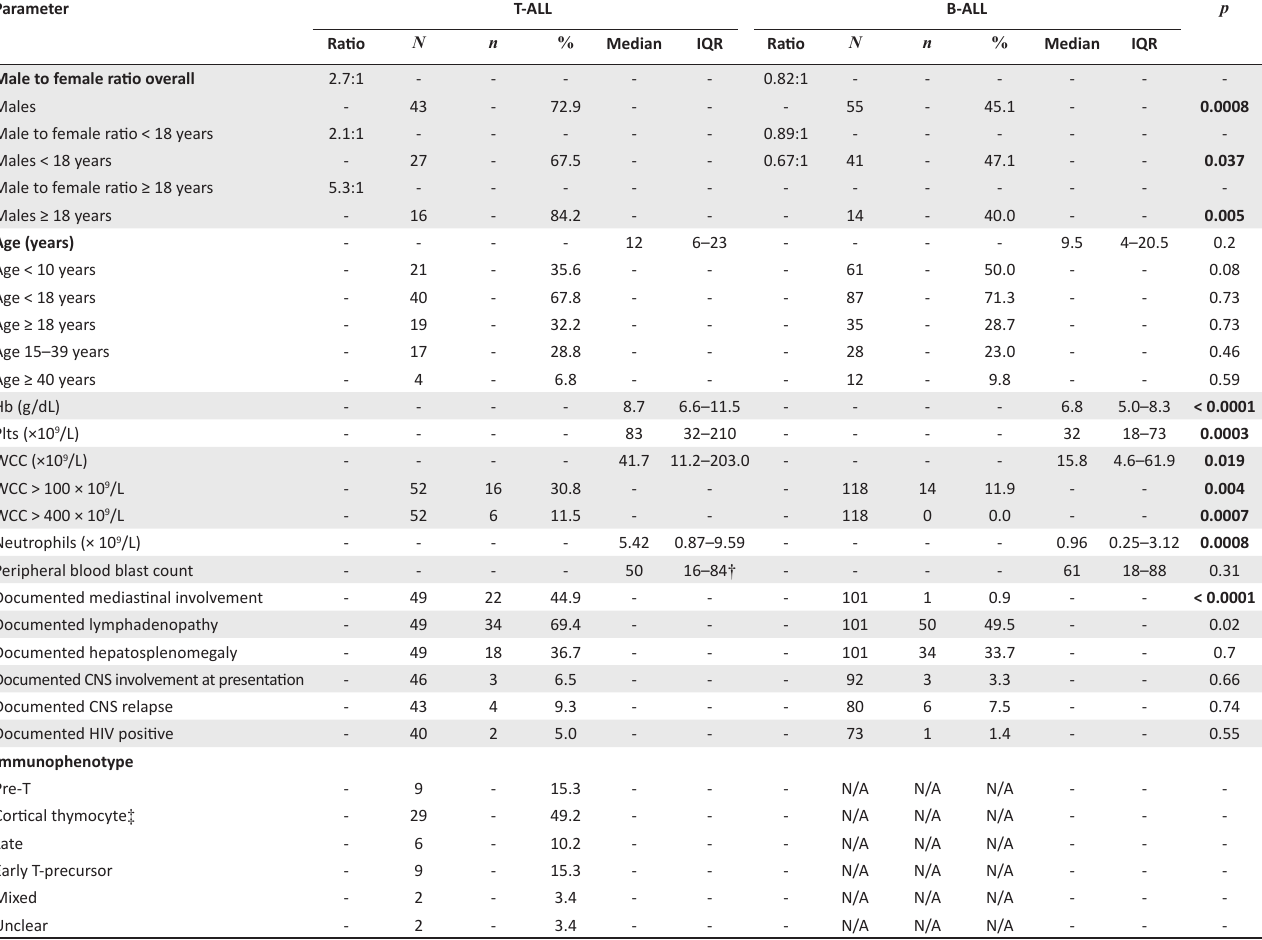
TABLE 1: Pertinent demographic and laboratory information in patients with T-cell lymphoblastic leukaemia as compared to those with B-ALL. Parameter